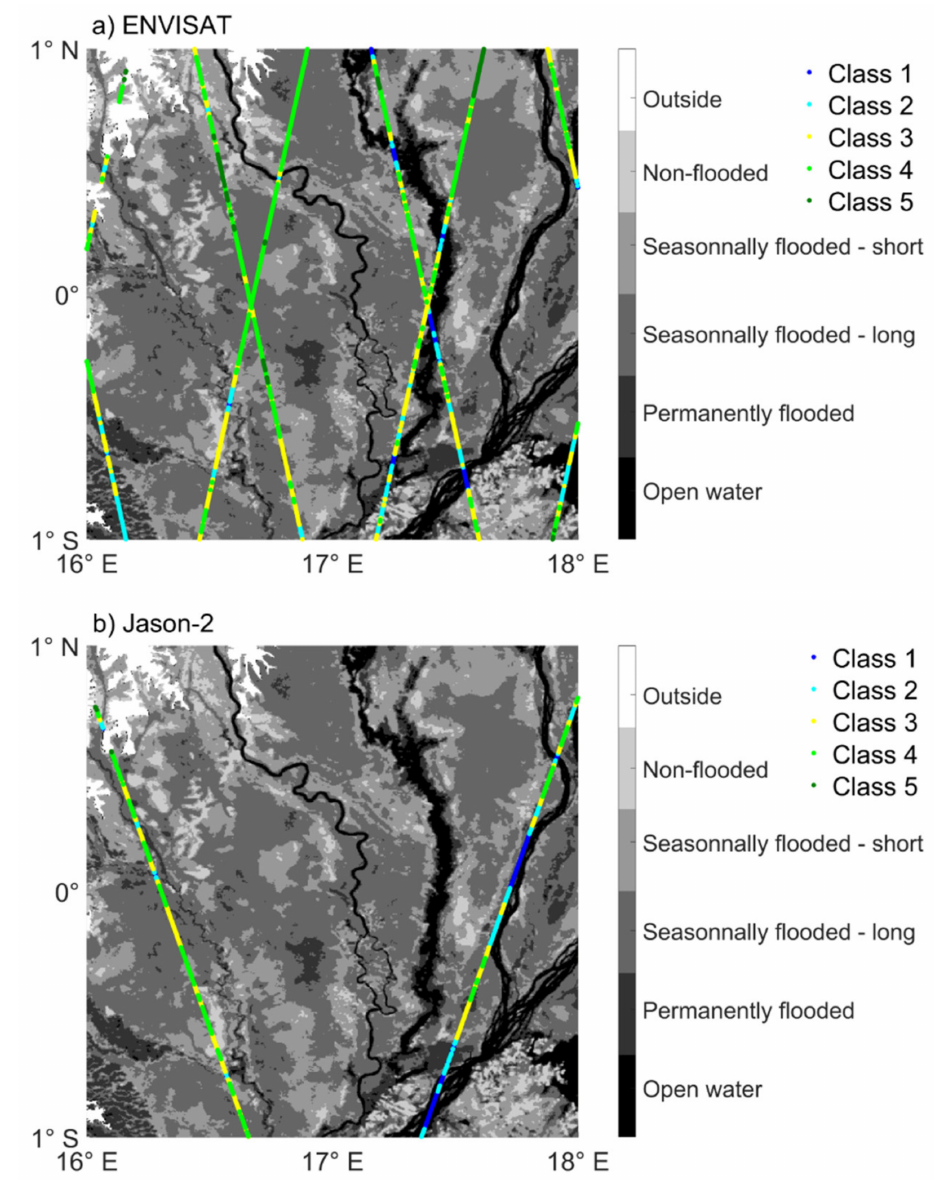
Figure 6. Same as Figure 5 for a smaller